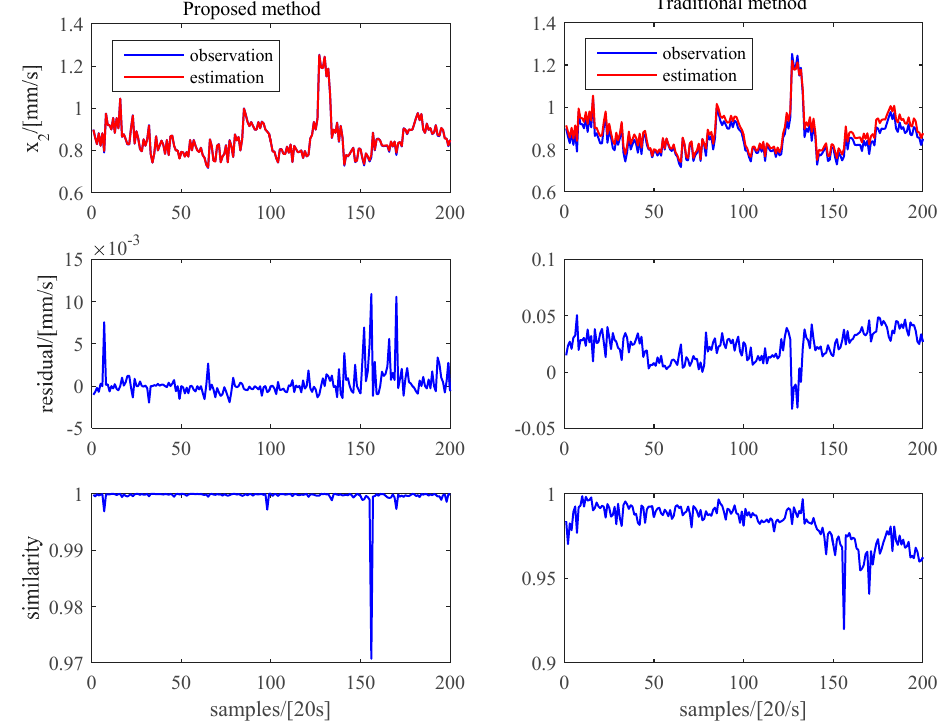
Figure 6. Comparison for proposed method and traditional method for vertical vibration in condition I.